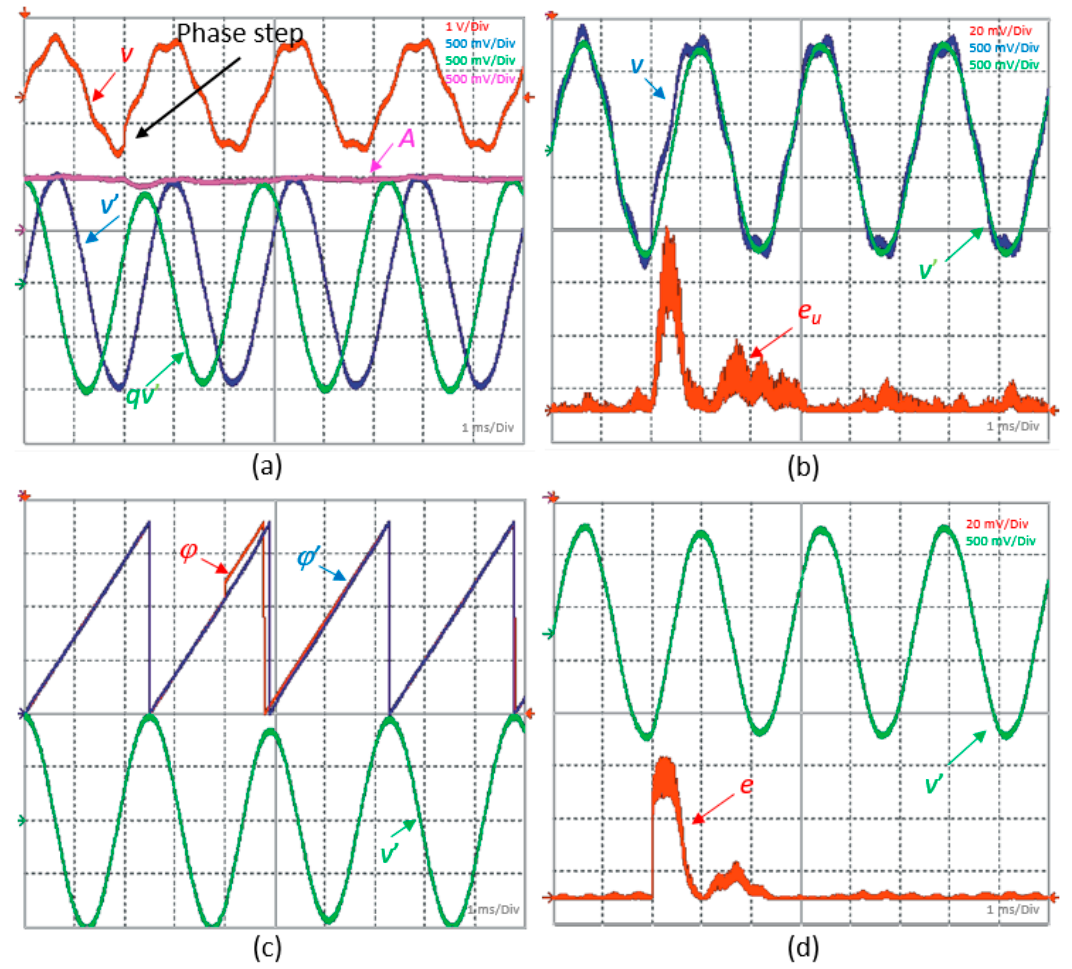
Figure 12. Dynamic performance of the proposed algorithm for phase jump of 30%: ( a ) waveforms of the input signal ( v ), estimated quadrature signals ( v ’ and qv ’) and estimated amplitude of input signal ( A ); ( b ) waveforms of the input signal ( v ), estimated sine signal ( v ’) and amplitude estimation error ( e A ); ( c ) waveforms of the estimated sine signal ( v ’), set angle ( ϕ ) and estimated angle ( ϕ ); ( d ) waveforms of the estimated sine signal ( v ’) and instantaneous estimation error ( e ).